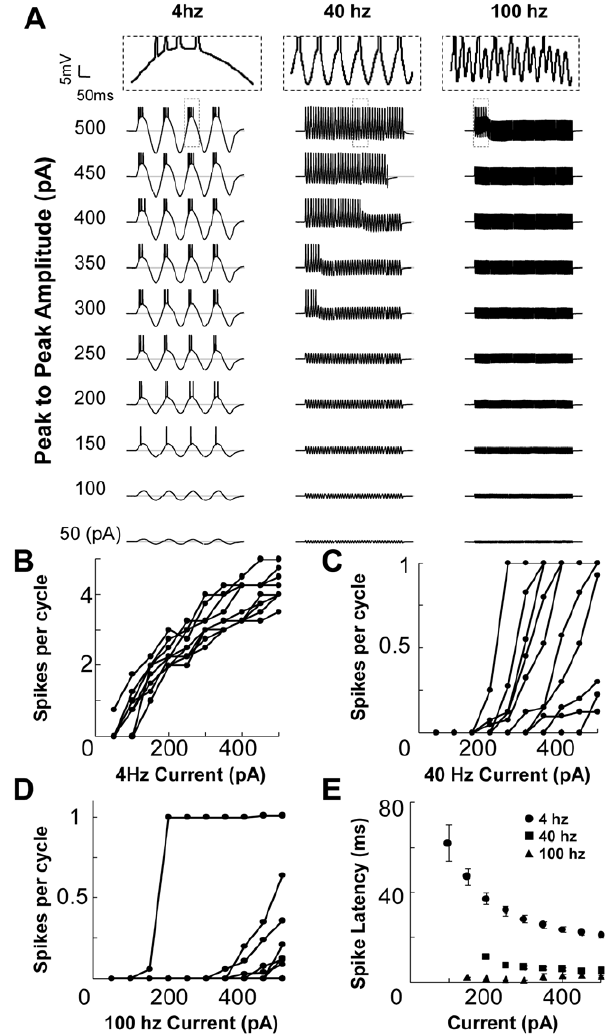
Figure 1. CA1 response entrained by sinusoidal current injection. ( A ) Sine current injection into a CA1 neuron at increasing peak to peak amplitude (y-axis) at 4 Hz, 40 Hz and 100 Hz (left to right). The APs have been clipped at 20 mV. Scale shown in the top left corner. Inset shows expanded views of the dashed box regions. The AP firing is entrained to the frequency of the sine wave especially with 4 Hz injection. Additionally, the cell spikes earlier in the cycle with increasing current amplitude. At 40 Hz, again the spikes are entrained to the frequency of the sine wave, but the cell goes into a quiet state after firing, possibly due to inactivation of active channels. In the 100 Hz case, it is difficult to make the cell fire even at high current amplitudes. ( B–D ) Average spikes per cycle as a function of peak-to-peak amplitude of current injected (N=11 cells) in the 4, 40 and 100 Hz cases. The firing rate is entrained by the frequency of current injection. The increase in firing rate is sigmoidal in the 40 Hz case. ( E ) The latency of the first spike shows significant phase advancement only with the theta frequency current injection. Error bars represent SE.